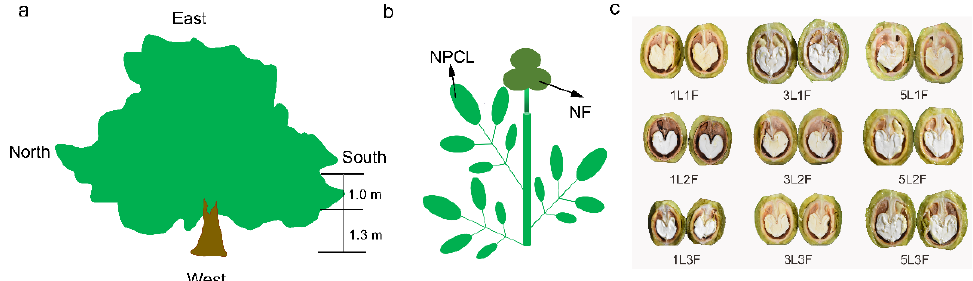
Figure 1. ( a ) Lateral view of the canopy. ( b ) Schematic diagram of a fruit bearing branch with a leaf − to − fruit ratio of 3:3 (3 NPCL : 3 NF ). ( c ) Representative walnut fruits from branches with 9 different leaf − to − fruit ratios. NPCL , number of pinnately compound leaves (1, 3, and 5). NF , number of fruits (1, 2, and 3).